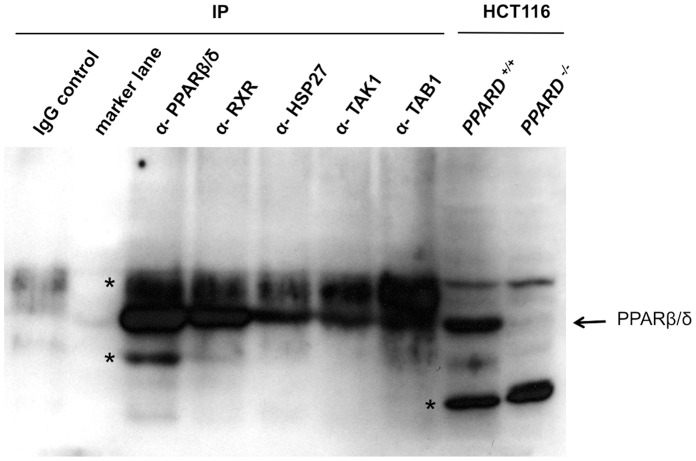
Interaction of endogenous PPARβ/δ with HSP27, TAK1 and TAB1.Untransfected HEK293T cells were treated with formaldehyde to stabilize protein interactions following the protocol for ChIP analyses. Cell extracts were prepared and immuneprecipitations were carried out with either irrelevant IgG or with antibodies against PPARβ/δ. RXR, HSP27, TAK1 or TAB1 (IP). Immunoblotting was performed with PPARβ/δ-specific antibodies. Antibodies against the established PPAR heterodimerization partner RXR were included as a positive control. The PPARβ/δ-HSP27 co-immunoprecipitation was abolished after pretreatment of the cell with HSP27 siRNA, confirming its specificity (not shown). The two rightmost lanes represent untreated extracts from HCT116 cells with intact (+/+) or disrupted (−/−) PPARD alleles [34] to allow for unambiguous identification of the PPARβ/δ band. *, non-specific band.